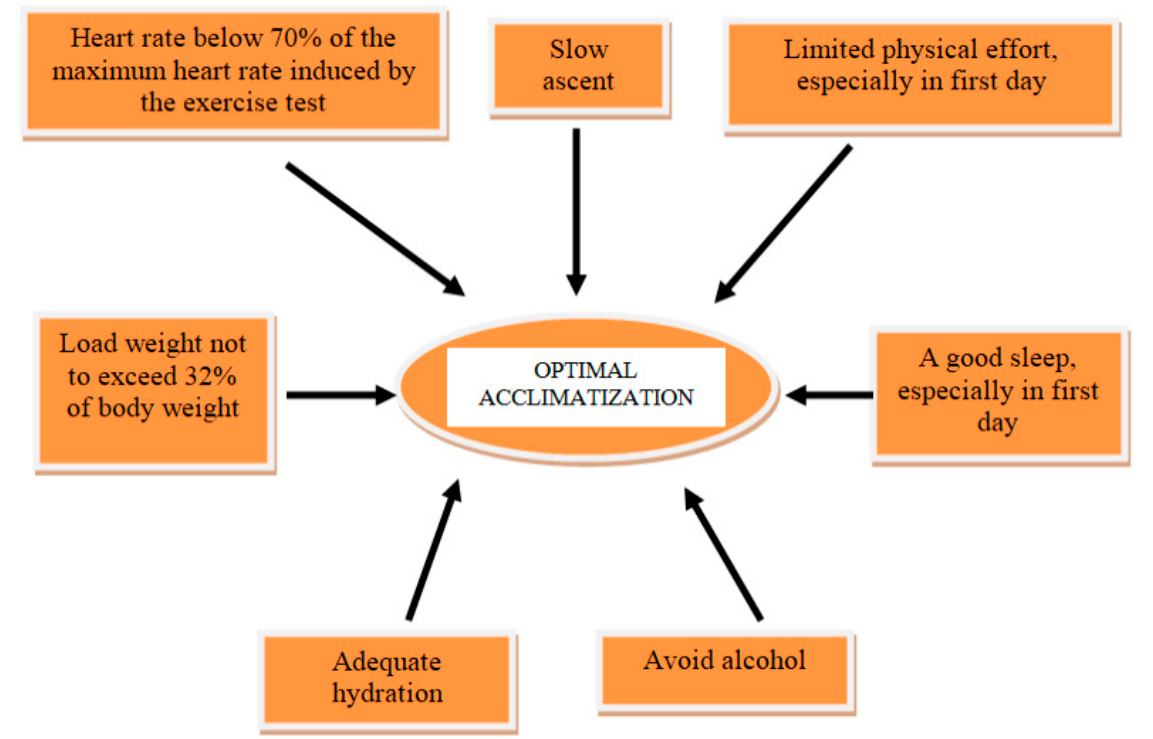
Figure 1. The most important measures for optimal acclimatization in CAD patients to HA expo- sure.